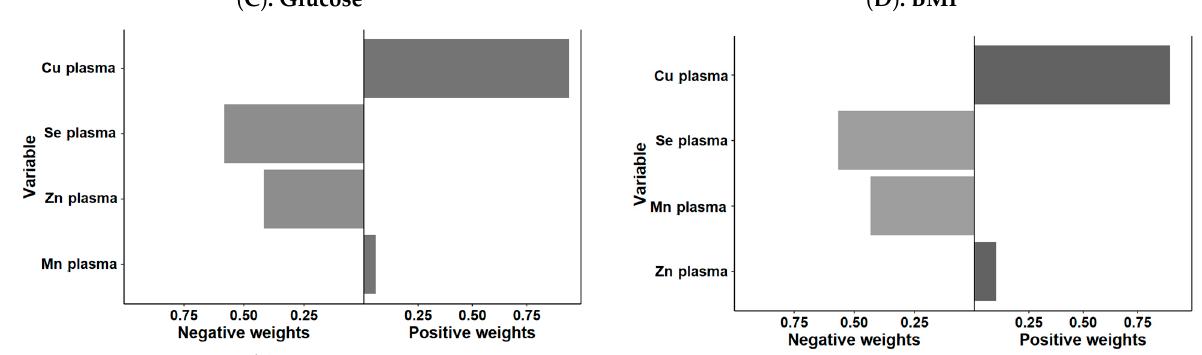
Figure 3. Overall mixture effect estimates and the weights of trace element contributions to the outcome (psi1 beta coefficients, 95% confidence intervals (CI), and p-values) for the combined association of plasma Zn, Cu, Se, and Mn with SBP (panel A ), DBP (panel B ), fasting glucose (panel C ), and BMI (panel D ) as continuous variables. Multivariable adjusted model.